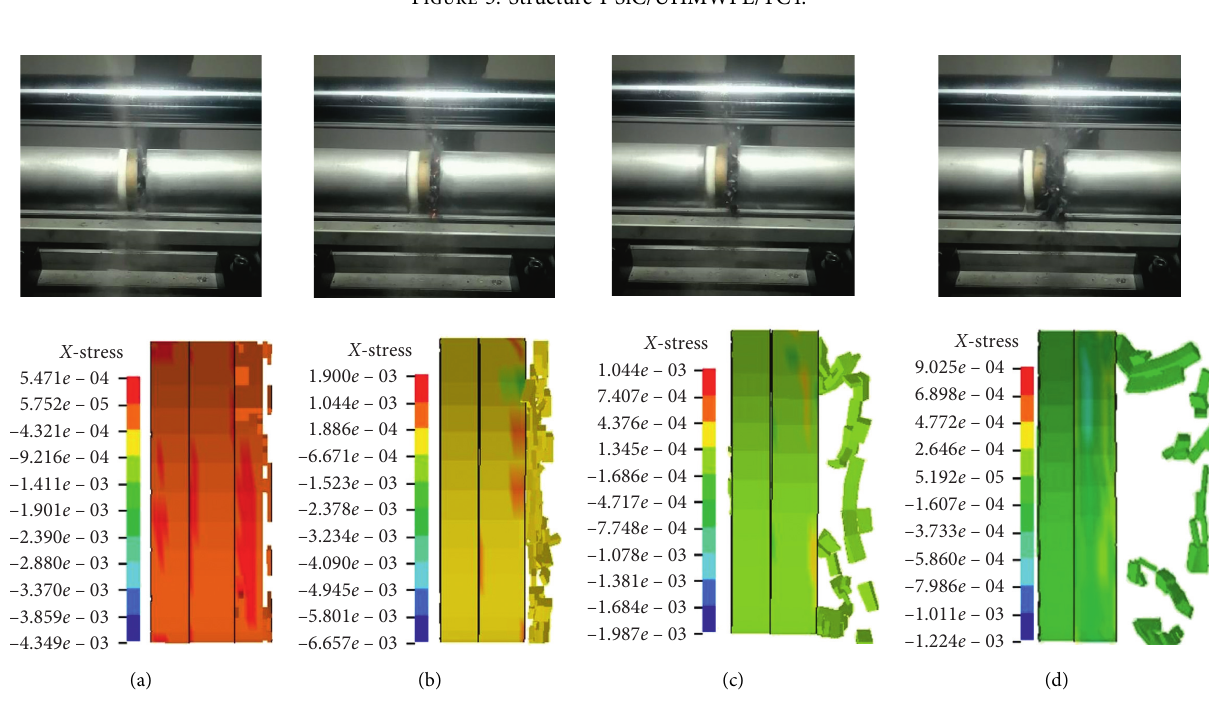
Figure 5: Structure I SiC/UHMWPE/TC4.